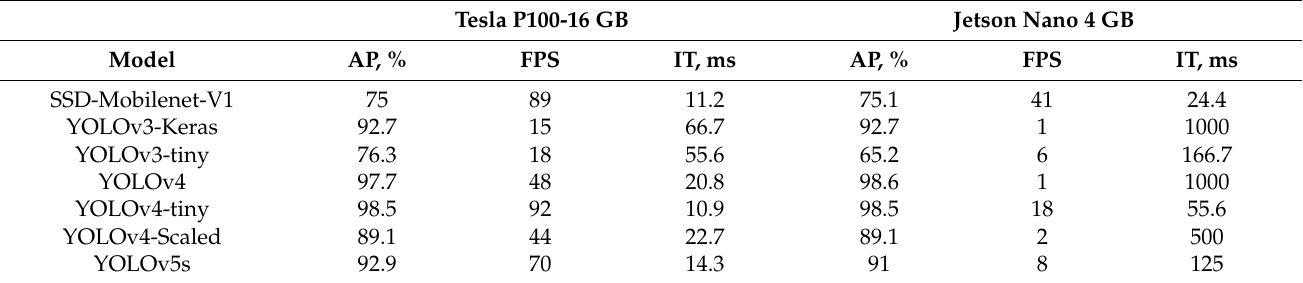
Table 3. Experimental results of investigated deep learning algorithm implementations for resistor detection. Tesla P100-16 GB